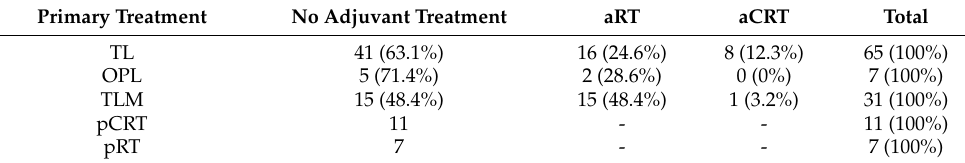
Table 2. Rate of adjuvant treatment depending on primary treatment for T3